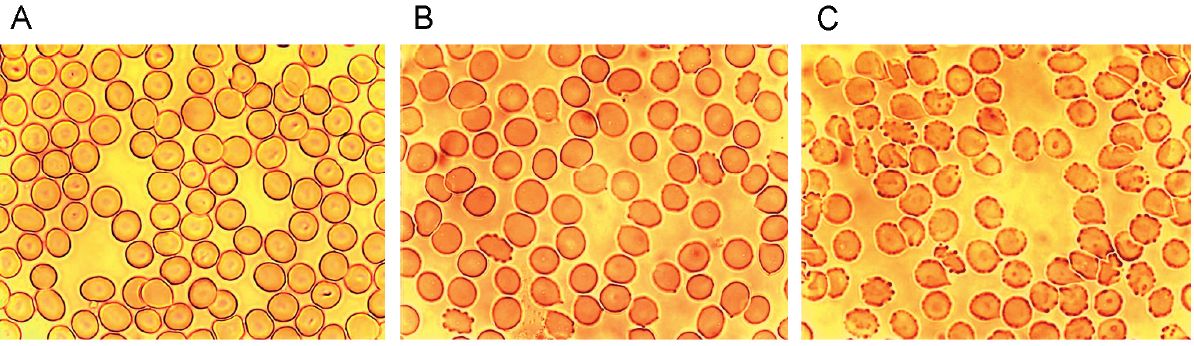
Figure 1. Radiographic contrast media (RCM)-induced echinocyte formation (reprinted from reference [6], Copyright 2008, with permission from IOS Press); ( A ) Erythrocytes resuspended in autologous plasma (40% v / v ); ( B ) Erythrocytes resuspended in an Iodixanol/plasma mixture (40% v / v ); ( C ) Erythrocytes resuspended in an Iopromide/plasma mixture (40% v / v